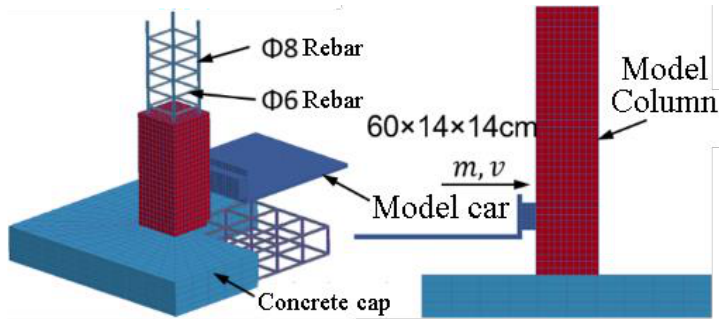
Figure 13. Finite element model of specimen.